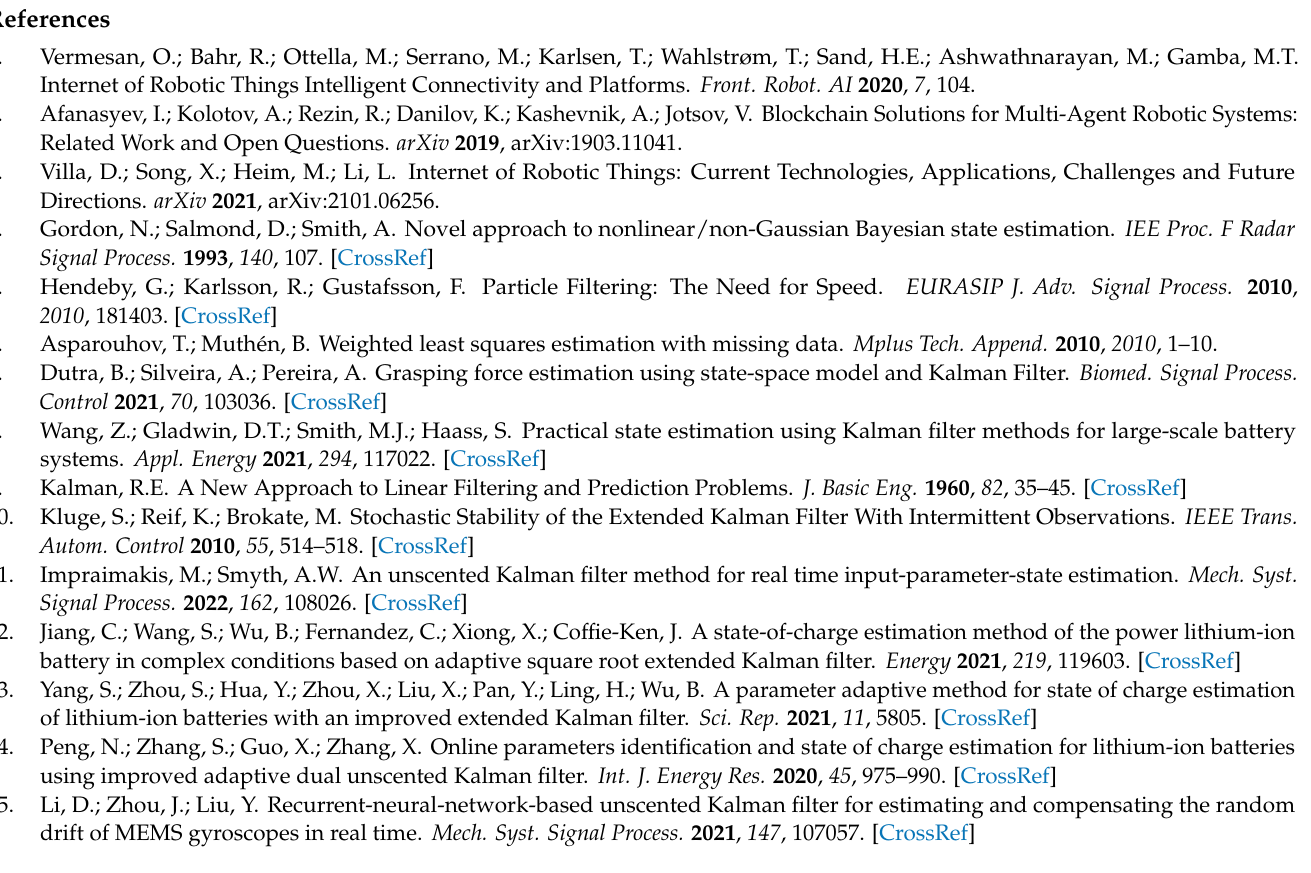
( o ) Experiment results for C-4 test. Figure A1. Results from the various